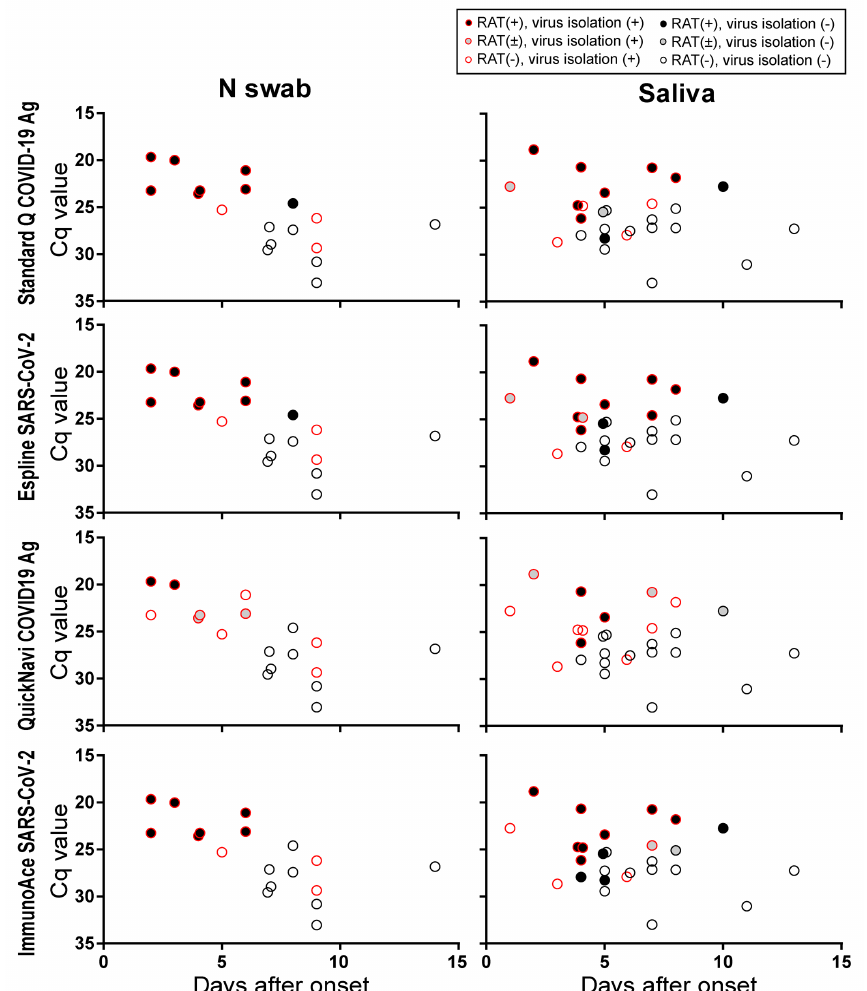
Figure 2. Results of RATs using N swabs and saliva specimens plotted based on the Cq value of RT-qPCR and days after onset. The results from the N swabs and saliva samples were extracted from Figure 1.